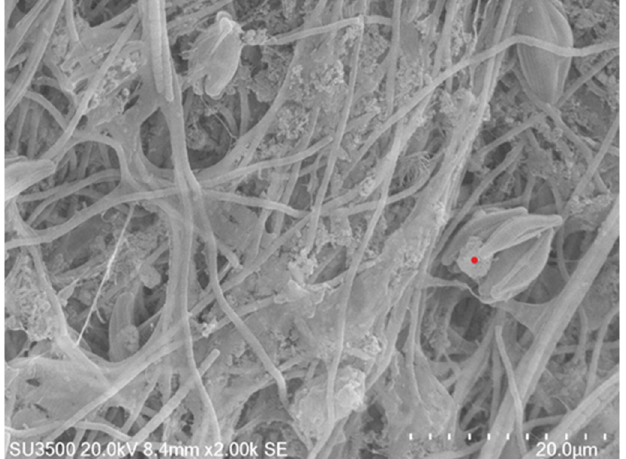
Figure 4. Scanning electron microscope (SEM) microphotograph of algae biofilm showing the formation of mineral phases on the cell surfaces. A typical composition of the inorganic precipitates (given by Energy-dispersive X-ray spectroscopy (EDX) analysis performed on the grain indicted by the red dot) is C (40.38% ± 4.01), O (47.2% ± 4.13), Mg (6.27% ± 0.21), and Si (6.15% ± 0.17), similar to the mineral phase (i.e., MgCO 3 and SiO 2 ).